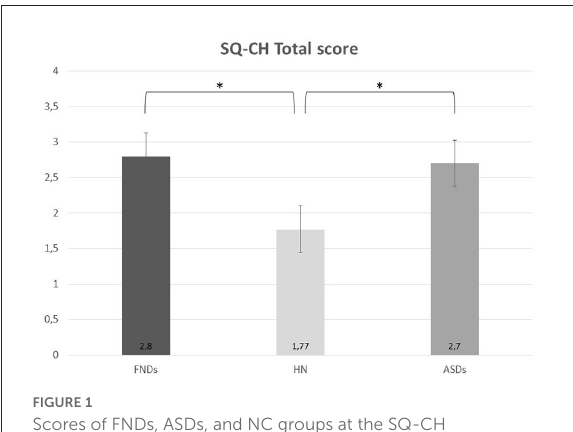
FIGURE1 Scores of FNDs, ASDs, and NC groups at the SQ-CH questionnaire. ASDs, autism spectrum disorders; FNDs, functional neurological disorders; NC, non-clinical comparison group. * p <